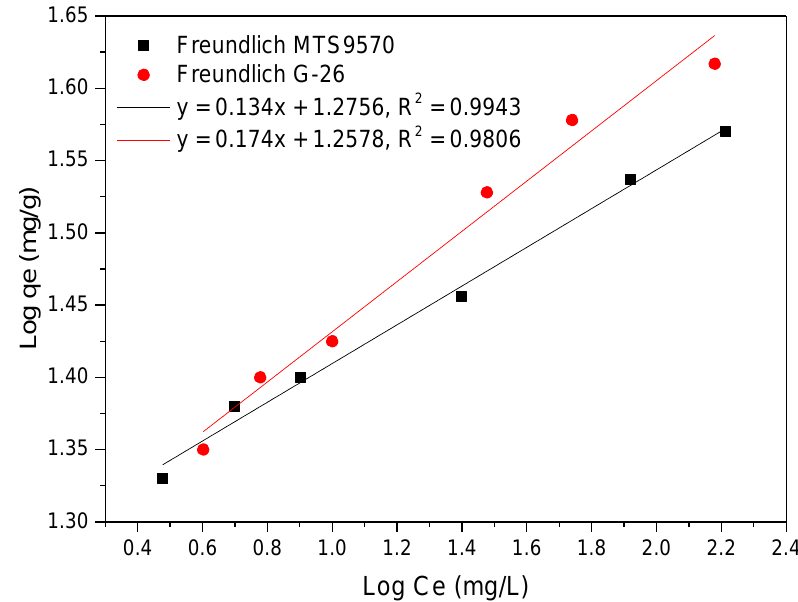
Figure 9. Freundlich isotherm of Pb(II) adsorption on G-26 and MTS9570.